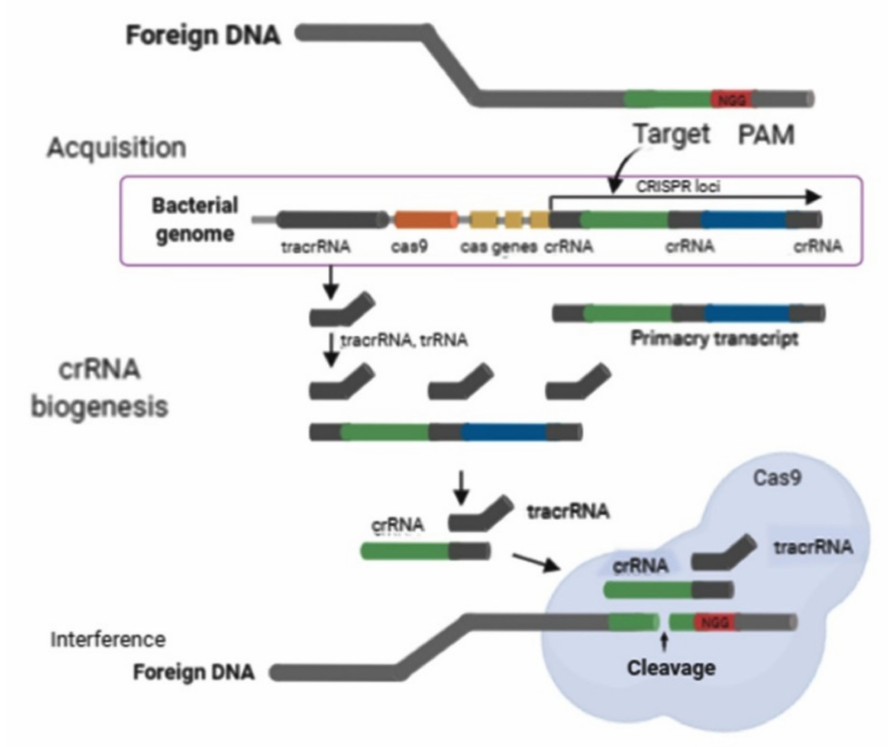
Figure 2. Mechanism of CRISPR/Cas9 system (illustration is adapted and modified from Arora et al.